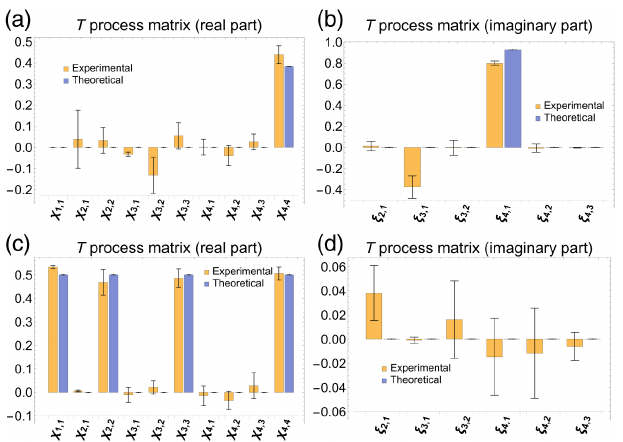
FIG. 12. Tomographic reconstruction of T unitary operator. From top left to bottom right: (a),(b) real and imaginary parts of process matrix, given correct decryption, and (c),(d) real and imaginary parts of process matrix, given wrong